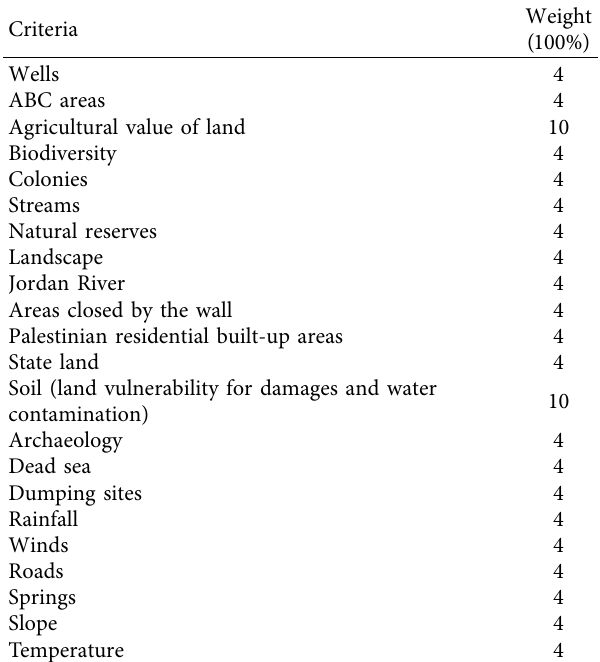
Table 5: Criteria